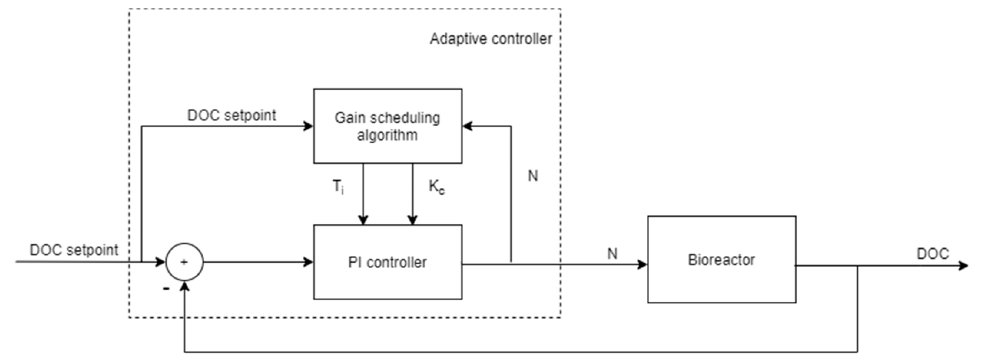
Figure 1. Block diagram of the dissolved oxygen concentration (DOC) control system.